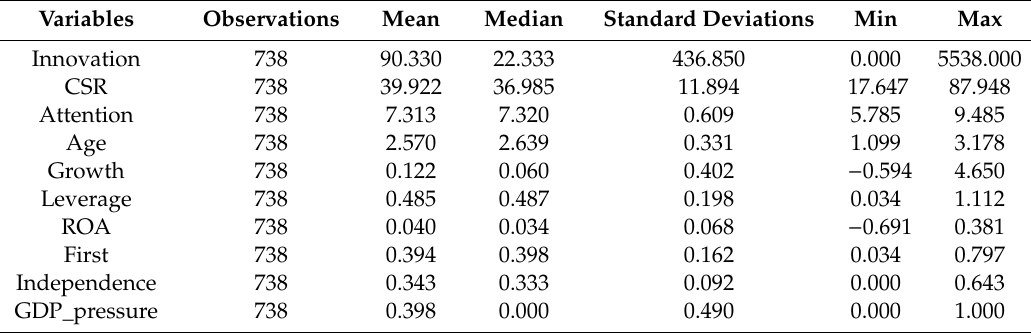
Table 2. Descriptive